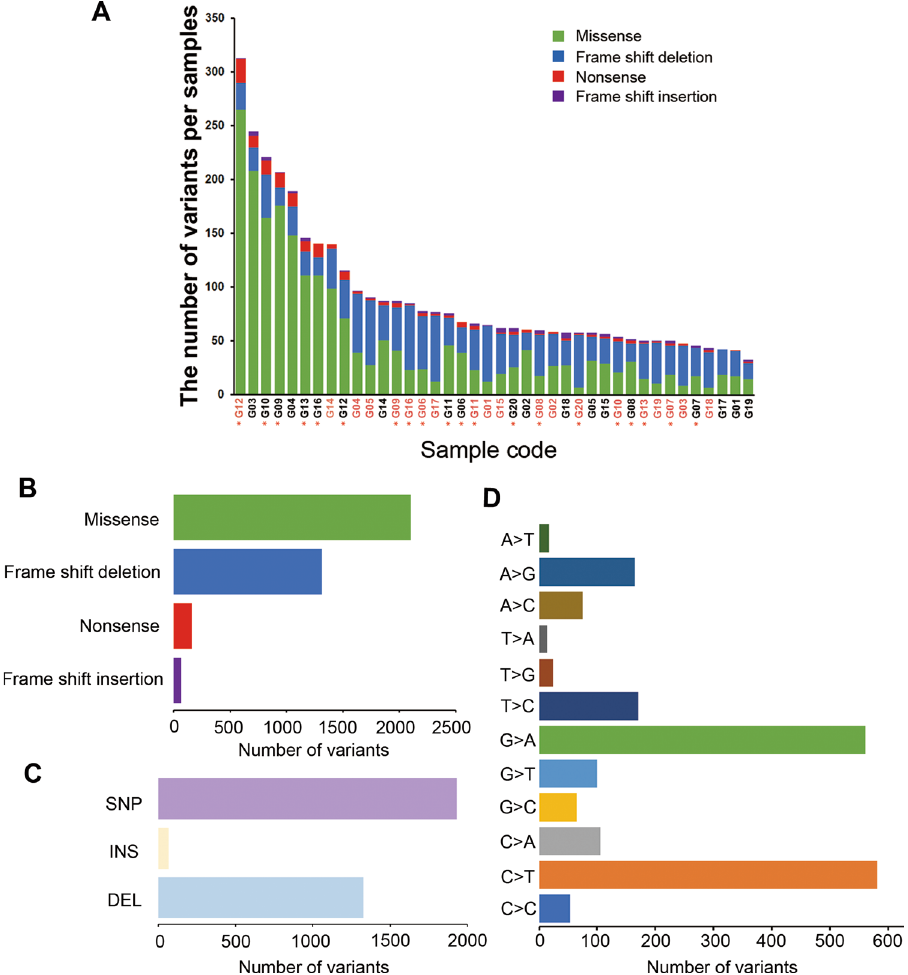
Figure 2. Summary of identified somatic variants. The total somatic variants in each sample, which are predicted to be protein altering, is displayed in a stacked bar plot ( A : orange names belong to cancerous tissue, black ones belong to adjacent non-cancerous specimens; the asterisk indicates the metachronous development group). The median numbers of total somatic variants, missenses, frame shift deletions, nonsense, and frame shift insertions are 63.5 (IQR, 52.5–95.5), 28 (IQR, 18–61), 30 (IQR, 23.5–39), 2 (IQR, 1–4.5), and 2 (IQR, 1–2.5), respectively. Variant types in a boxplot summarized by variant classification ( B ) and type ( C ), and by SNP class ( D ). SNP single nucleotide polymorphism, INS insertion, DEL